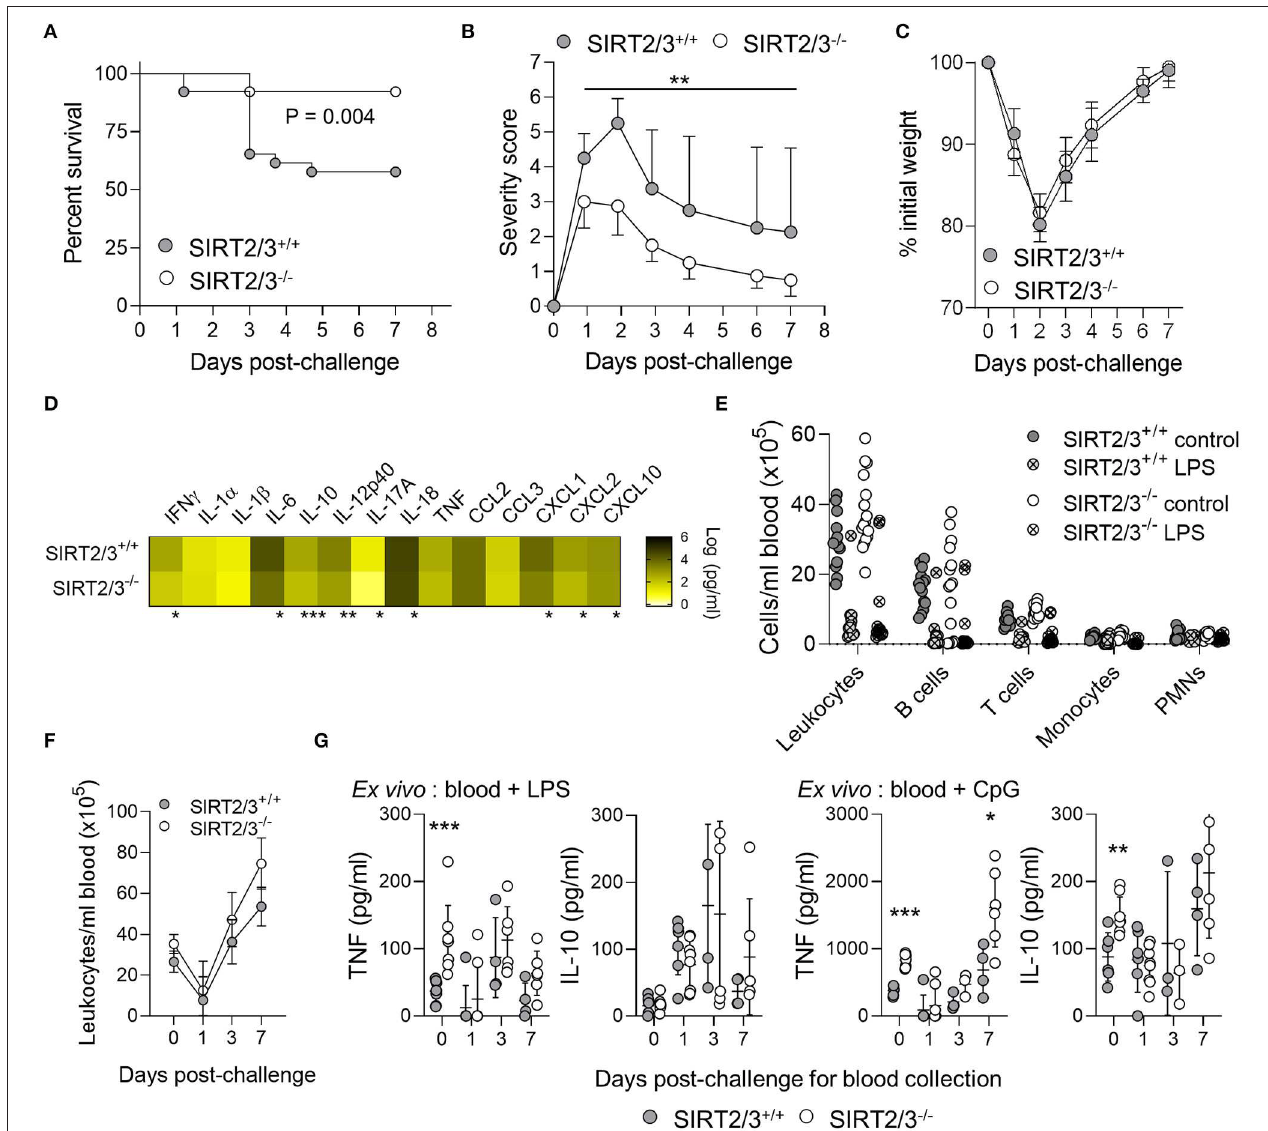
FIGURE 5 | SIRT2/3 − / − mice are protected from endotoxic shock. Mice were challenged with 10 mg/kg LPS i.p. Survival (A) , severity score (B) , and weight loss (C) were recorded daily. Data are mean ± SD (B,C) . (D–G) Blood was collected 0, 1, 3, and 7 days post-challenge to quantify the concentrations of cytokines by Luminex ( D , at day 1 post-challenge) and leukocytes by flow cytometry ( E,F , at day 1 post-challenge in E ). Blood collected 0, 1, 3, and 7 days post-LPS challenge was stimulated ex vivo for 6h with 10ng/ml LPS and 10 µ M CpG. TNF and IL-10 concentrations were measured by ELISA (G) . TNF and IL-10 concentrations in blood cultured for 6h without stimulation were below the detection limit (not depicted on the graphs). Data were obtained from 26 (A) , 7–8 (B,C,F,G) , 4 (D) , and 14–16 (E) mice per group. * P < 0.05; ** P < 0.01; *** P <